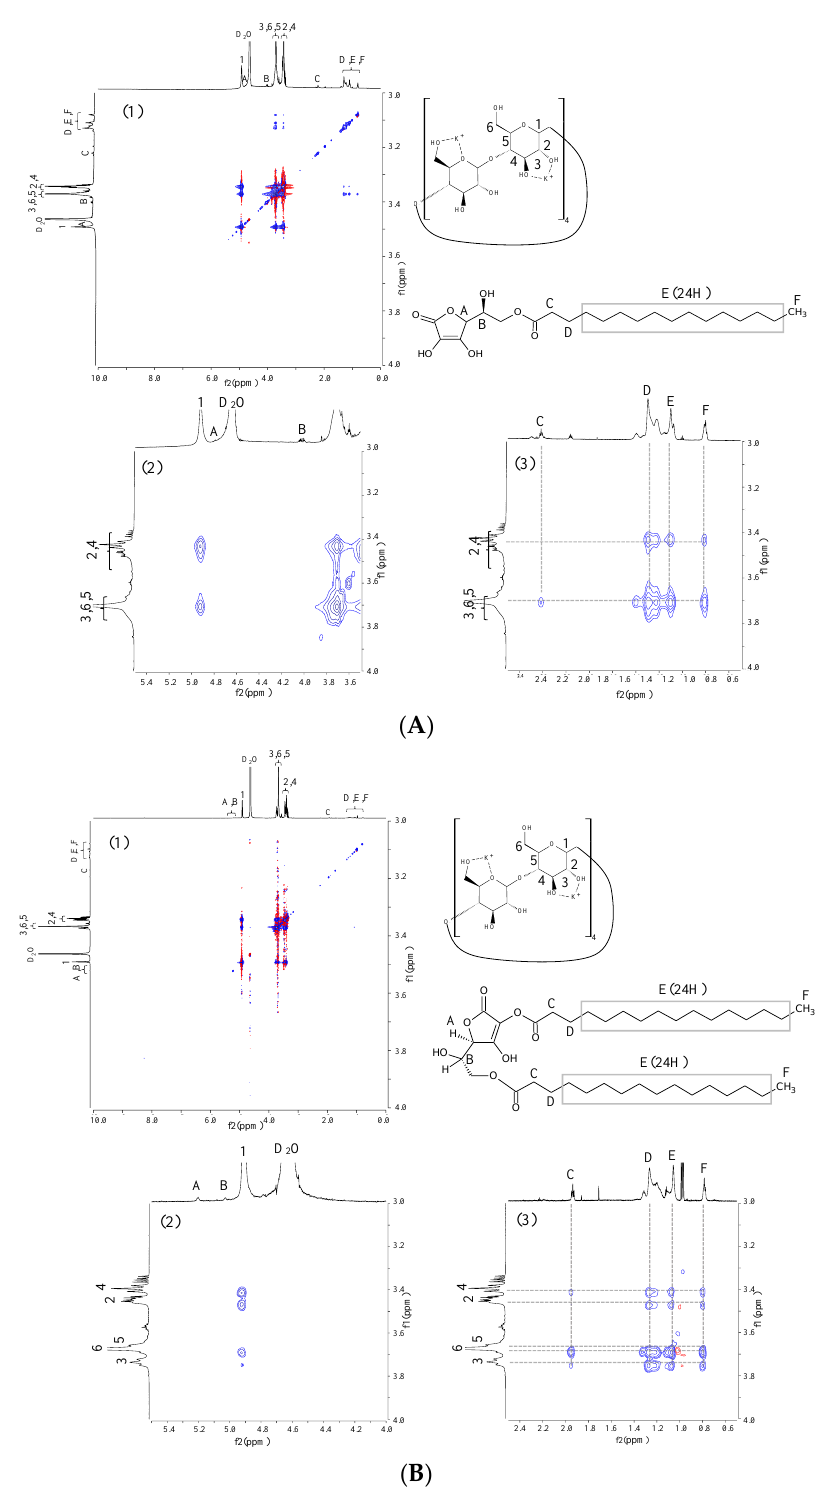
Figure 6. ( A ) 1 H- 1 H NOESY NMR spectra EVP (ASCP/CD-MOF-1 = 1/2) in D 2 O: ( 1 ) f1 is 3.0 – 4.0 ppm, f2 is 0.0 – 10.0 ppm; ( 2 ) f1 is 3.0 – 4.0 ppm, f2 is 3.5 – 5.5 ppm; ( 3 ) f1 is 3.0 – 4.0 ppm, f2 is 0.5 – 2.5 ppm. ( B ) 1 H- 1 H NOESY NMR spectra EVP (ASCDP/CD-MOF-1 = 1/4) in D 2 O: ( 1 ) f1 is 3.0 – 4.0 ppm, f2 is 0.0 – 10.0 ppm; ( 2 ) f1 is 3.0 – 4.0 ppm, f2 is 4.0 – 5.5 ppm; ( 3 ) f1 is 3.0 – 4.0 ppm, f2 is 0.5 – 2.5 ppm.